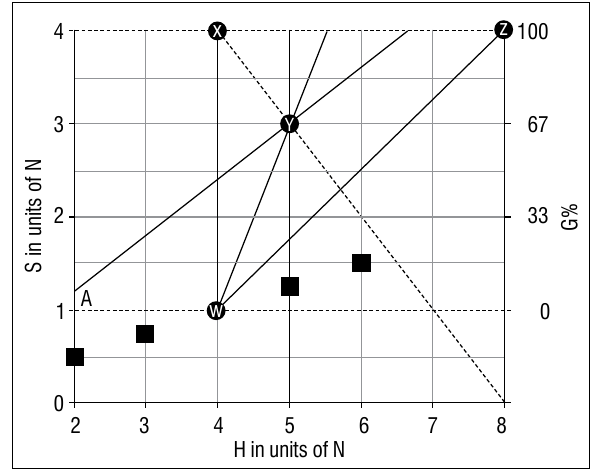
Figure 1: Admissible region for H (headcounts) and S (successful credits) in the H-S plane for K=4 and L=0.5, where K is the average number of years studied by students dropping out at the end of the year and L is the balance of failed and unutilised credits; N is the